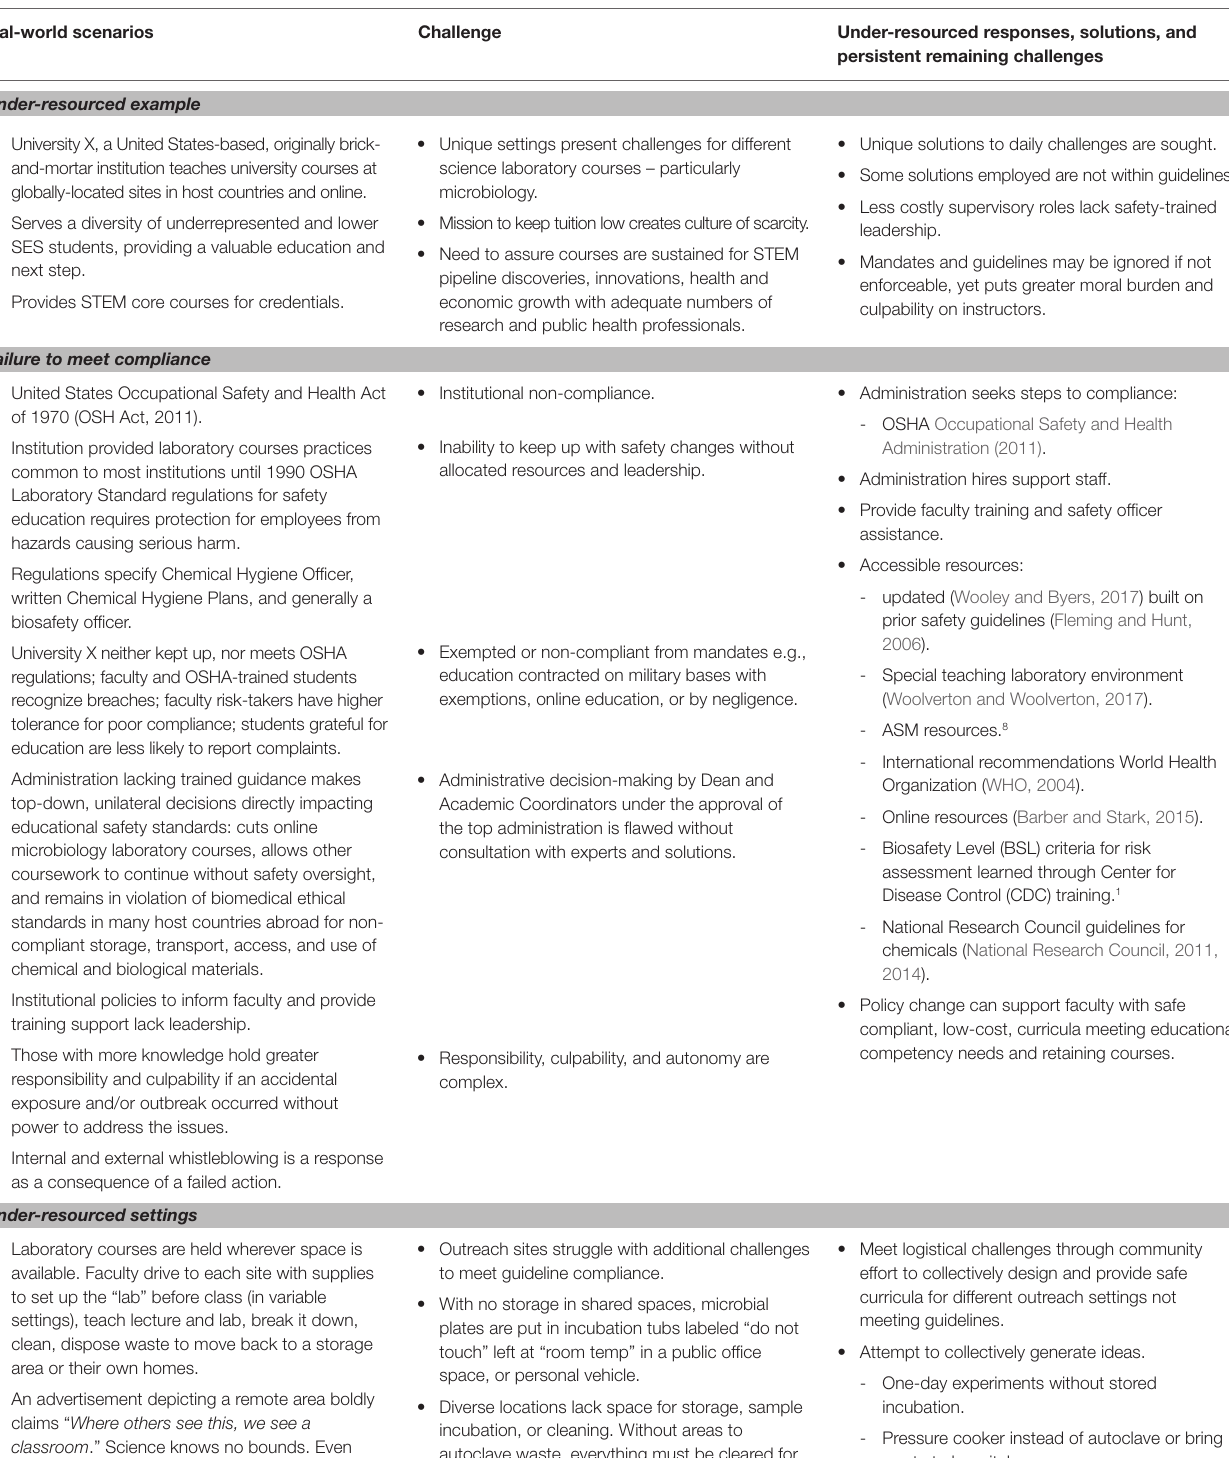
TABLE 1 | Sample University X under-resourced teaching laboratory scenario. Real-world scenarios